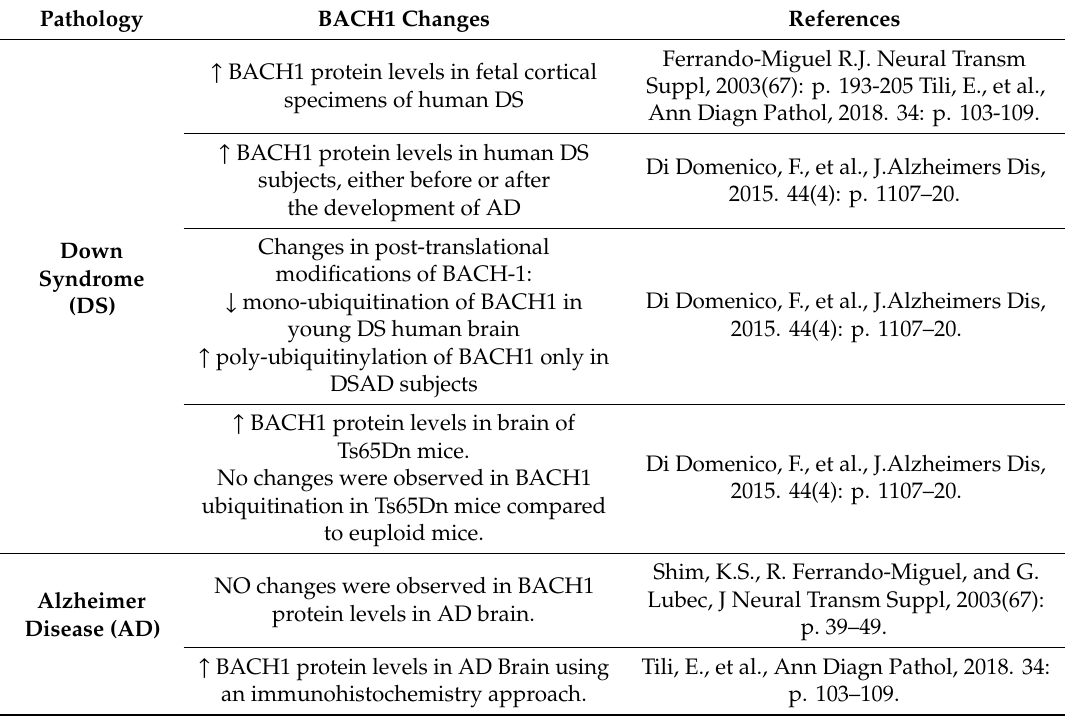
Table 2. Summary of BACH-1 alterations observed in Down syndrome and Alzheimer